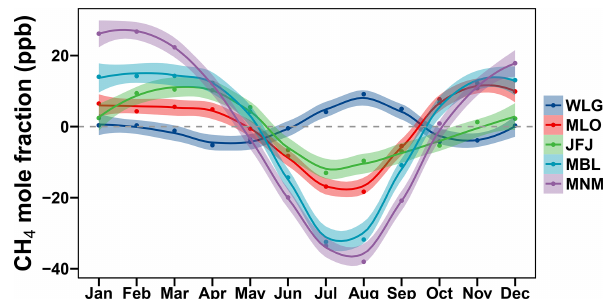
Figure 11. The seasonal cycles of atmospheric CH 4 observed at the WMO/GAW global stations of Mauna Loa (MLO; 1994–2018), Jungfraujoch (JFJ; 2005–2018), Minamitorishima (MNM; 1994– 2019), and Mt. Waliguan (WLG; 1994–2019) in the Northern Hemi- sphere. The data of other sites (except WLG) are from the World Data Centre for Greenhouse Gases (WDCGG). The data in the ma- rine boundary layer (MBL; 1994–2019) are from NOAA/ESRL lab- oratory at a similar latitude to